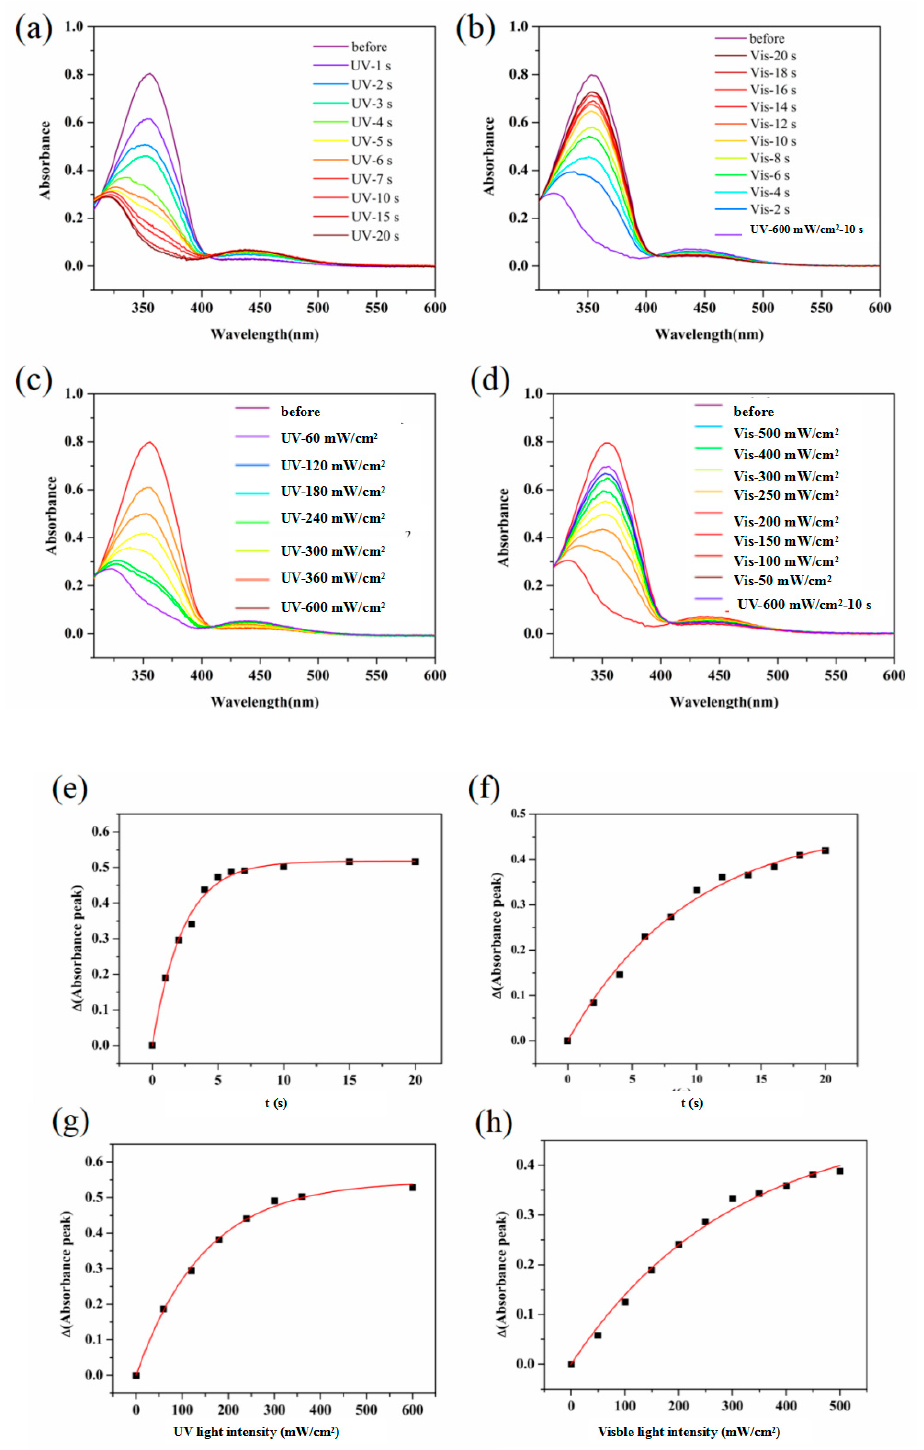
Figure 3. ( a – d ) UV / V is absorption spectra of 6cazpy in toluene at room temperature. ( e – h ) plots of change of absorbance peak ( ∆ (Absorbance peak)) with time or light intensity. In each sample, the spectra ( a , e ) obtained upon UV light ( λ = 365 nm, 60 mW / cm 2 ) irradiation with di ff erent irradiating time, ( b , f ) obtained upon visible light ( λ = 530 nm, 100 mW / cm 2 ) irradiation with di ff erent irradiating time after the 600 mW / cm 2 UV light irradiation, ( c , g ) obtained upon UV light ( λ = 365 nm, t = 1 s) irradiation using di ff erent intensity, ( d , h ) obtained upon irradiation with visible light ( λ = 530 nm, t = 4 s) using di ff erent intensity after the 600 mW / cm 2 UV light